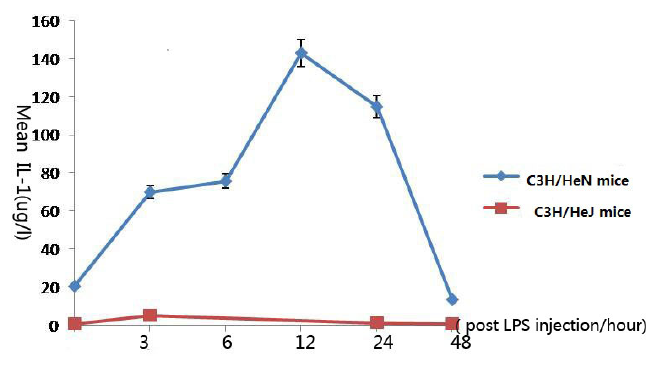
Figure 2. The expression levels of interleukin-1 in the aqueous humor at different time points (expressed as the mean μ g/L ± SD). The concentration of IL-1 in the aqueous humor of C3H/HeN mice increased significantly 3 h after injection, reached a peak at 12 h after injection, then gradually decreased, and returned to its original concentration 48 h after injection. The concentration of IL-1 in the aqueous humor of C3H/HeJ mice reached a peak at 3 h after injection, then gradually decreased, and returned to its original concentration 48 h after